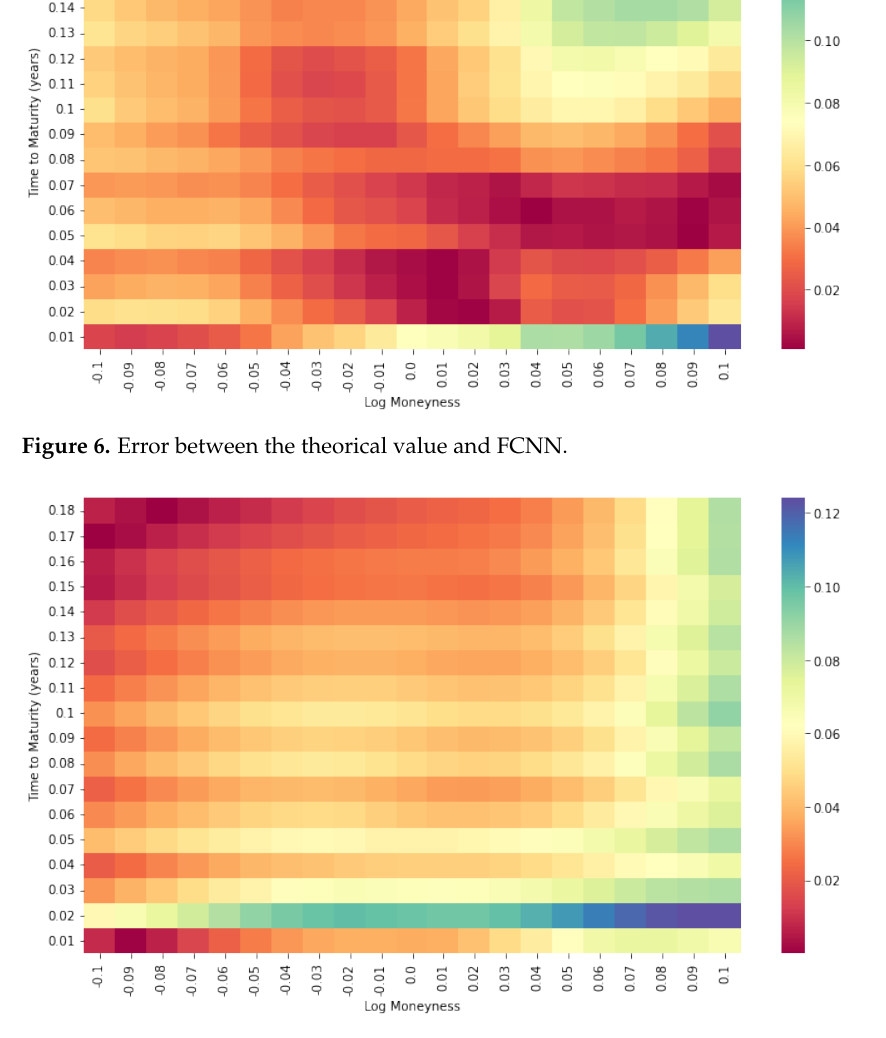
Figure 7. Error between the theoretic value and the